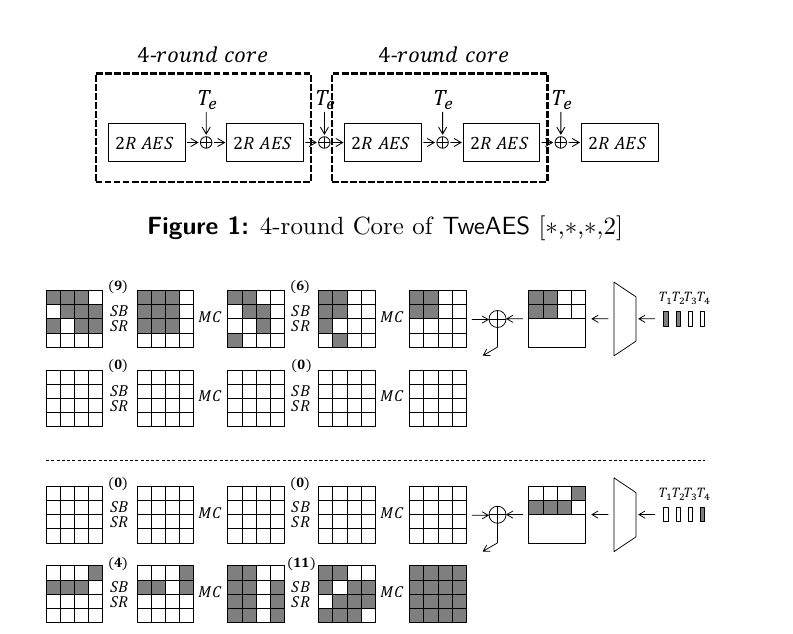
Figure 2: TweAES : Two Examples of Differential Trails with 15 Active